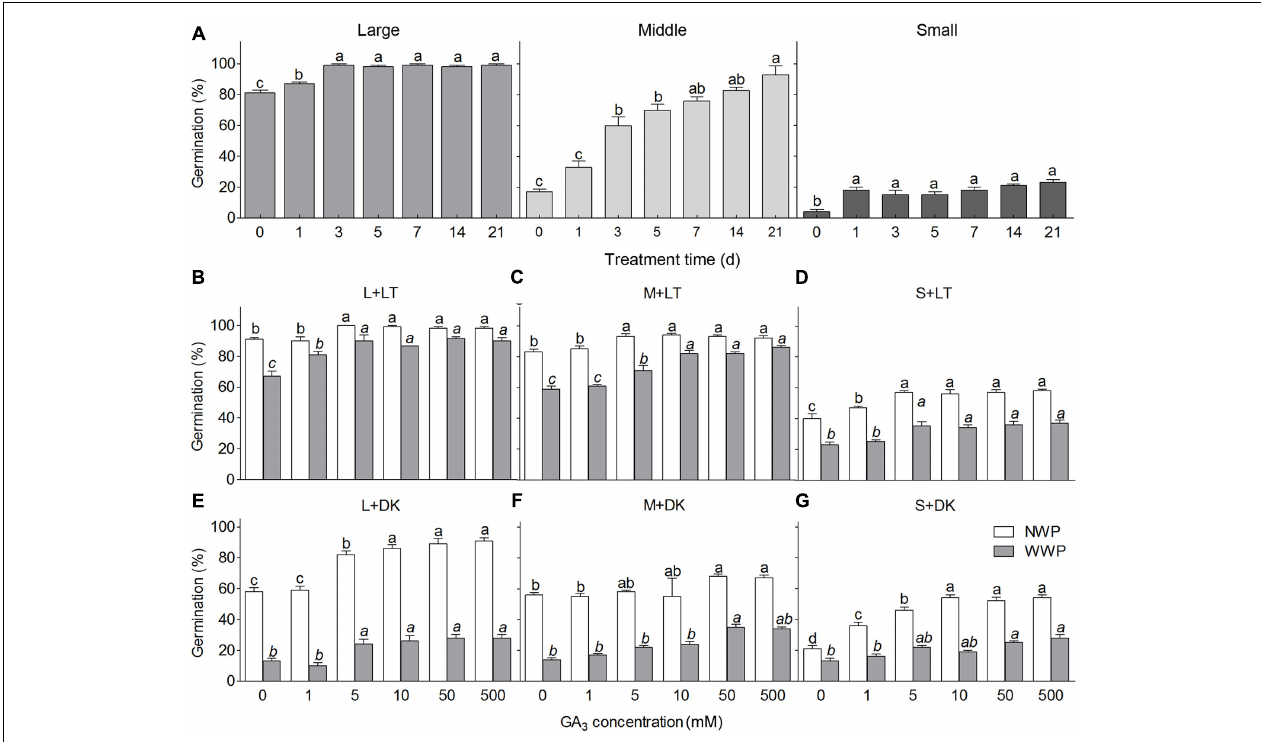
FIGURE 9 | Effect of cold stratification (A) , GA 3 treatment (B–G) on germination of heteromorphic seeds of S. ferganica. L, M, S, large, middle, small seed. LT, light; DK, dark. NWP, non-winged perianth; WWP, with winged perianth. Bars with different lowercase letters indicate significant differences ( P < 0.05) according to the Tukey’s test. Values are means ± SE of four